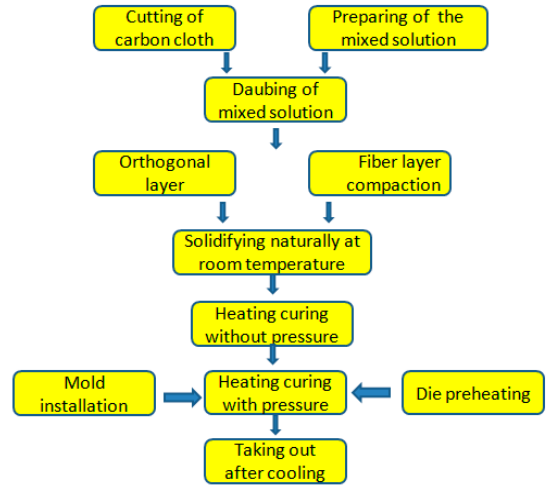
Figure 2. Process of preparing 2D-T700/E44 composite materials by ICM. Table 1. Process parameters of improved compression molding (ICM) for preparing 2D-T700/ E44